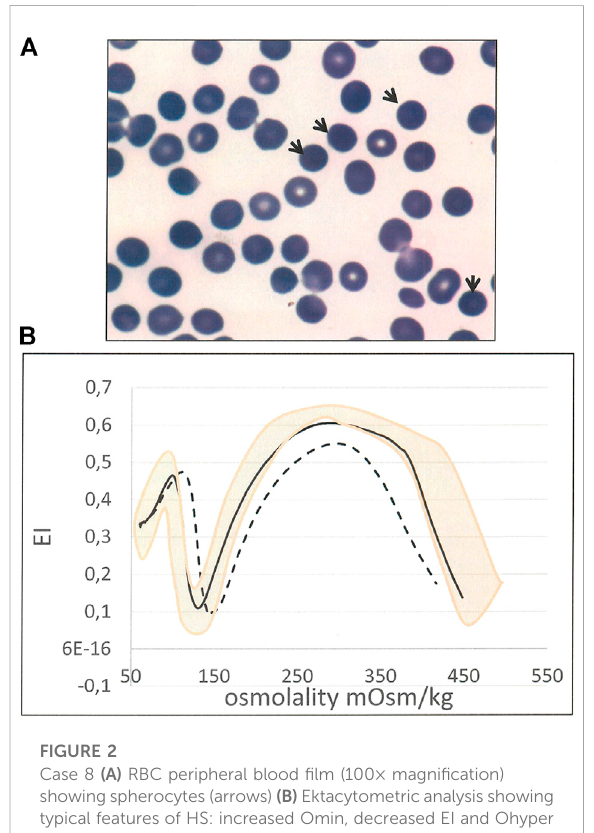
FIGURE 2 Case 8 (A) RBC peripheral blood fi lm (100× magni fi cation) showingspherocytes (arrows) (B) Ektacytometricanalysis showing typical features of HS: increased Omin, decreased EI and Ohyper and AUC, in the patient (dotted line) compared with normal control (black line). Pink area represents the area covered by normal